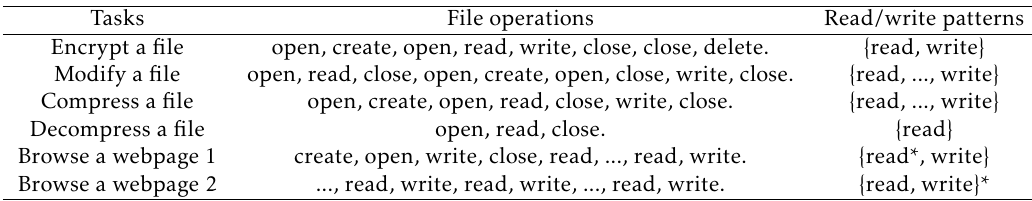
Table 1. Read/write patterns of different tasks